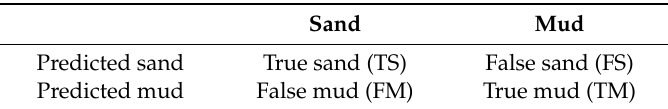
Table 2. Confusion matrix